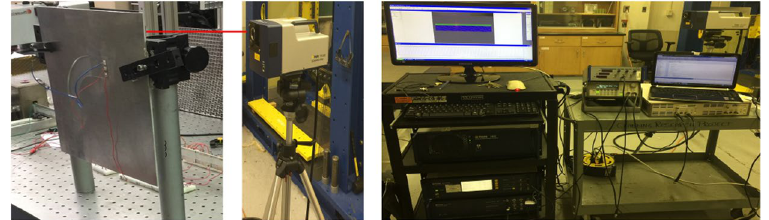
Figure 6. Experimental setup showing an aluminum plate hosting piezoelectric transducers for exciting waves, a function generator and amplifier for generating requisite voltage profiles, and a laser vibrometer for measuring the backside transverse plate